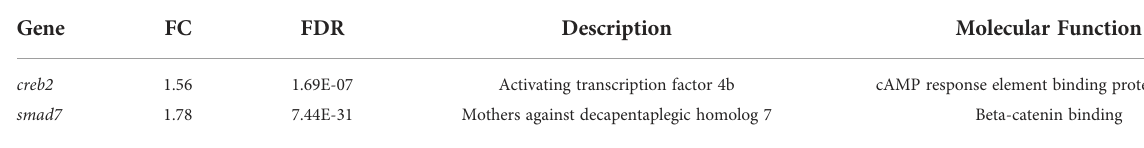
FC, fold change; FDR, false discovery rate.